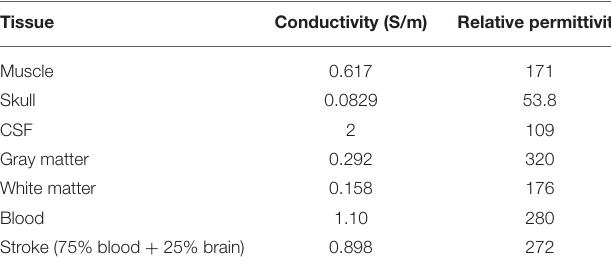
TABLE 1 | Dielectric properties at 10 MHz assigned to each tissue type in the head model.